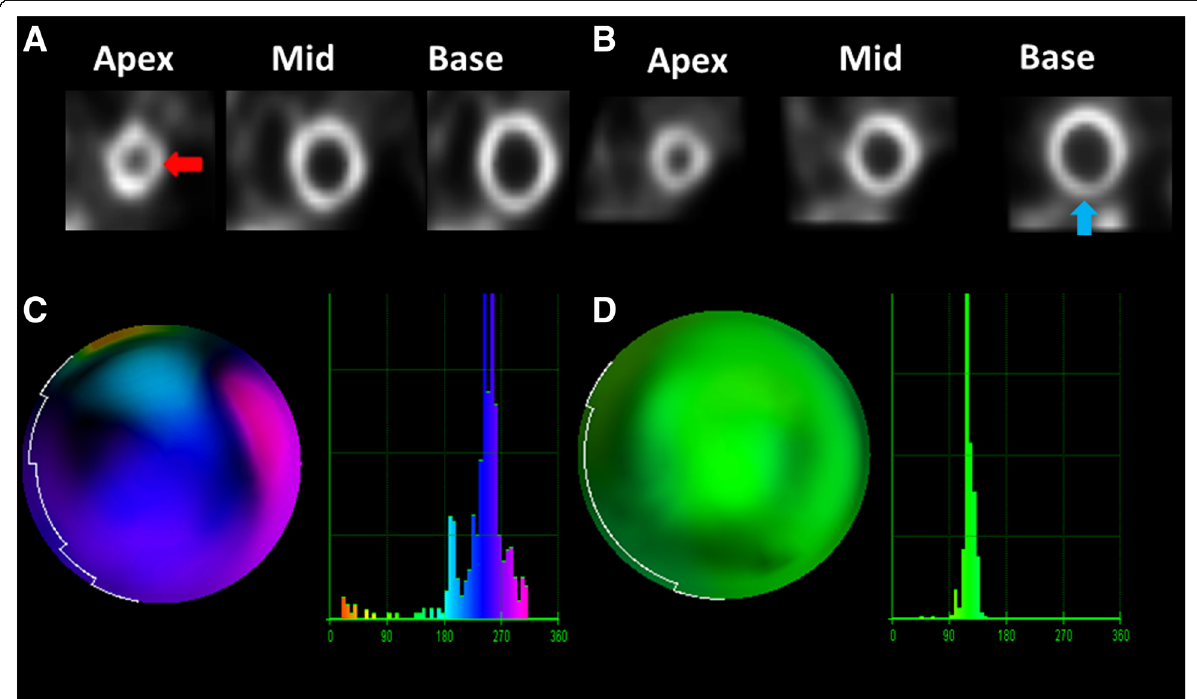
Fig. 4 Comparative cases demonstrating use of phase analysis in instances of questionable resting defect (scar). A 74-year-old male with a history of hypertension, hyperglycemia and obstructive sleep apnea presented with 4 months of exertional dyspnea and palpitations was referred for radionuclide stress testing. Short-axis rest and stress images displaced from apex to base ( a ) demonstrated a possible resting perfusion defect in the lateral portion of the apex (red arrow). b A 76-year-old obese, hypertensive male presented with complaints of 3 months of exertional dyspnea underwent radionuclide stress testing which revealed a possible resting defect in the basal inferior segment (blue arrow). c Resting polar map and histogram of patient from case ( a ) demonstrating significant dyssynchrony, with an entropy 72%. Compare these findings with the polar map and histogram ( d ) of the second patient ( b ) which demonstrates synchrony with entropy